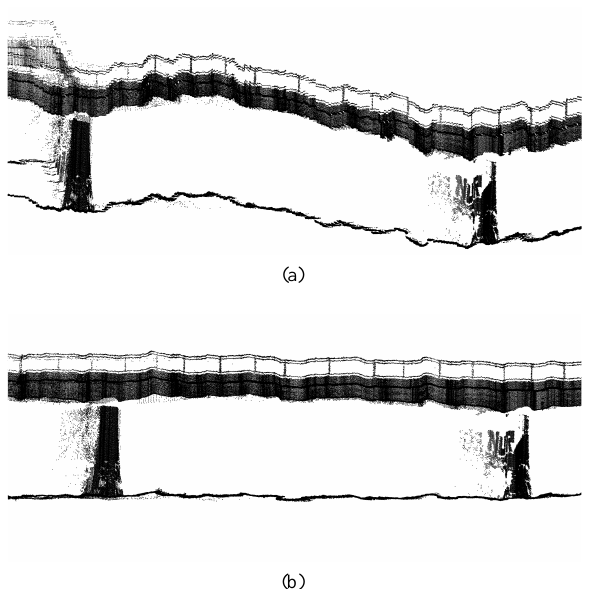
Figure 7: Effects of inaccurate GPS-height measurements: (a) LSRF point cloud with GPS-heights. (b) LSRF point cloud with barometric